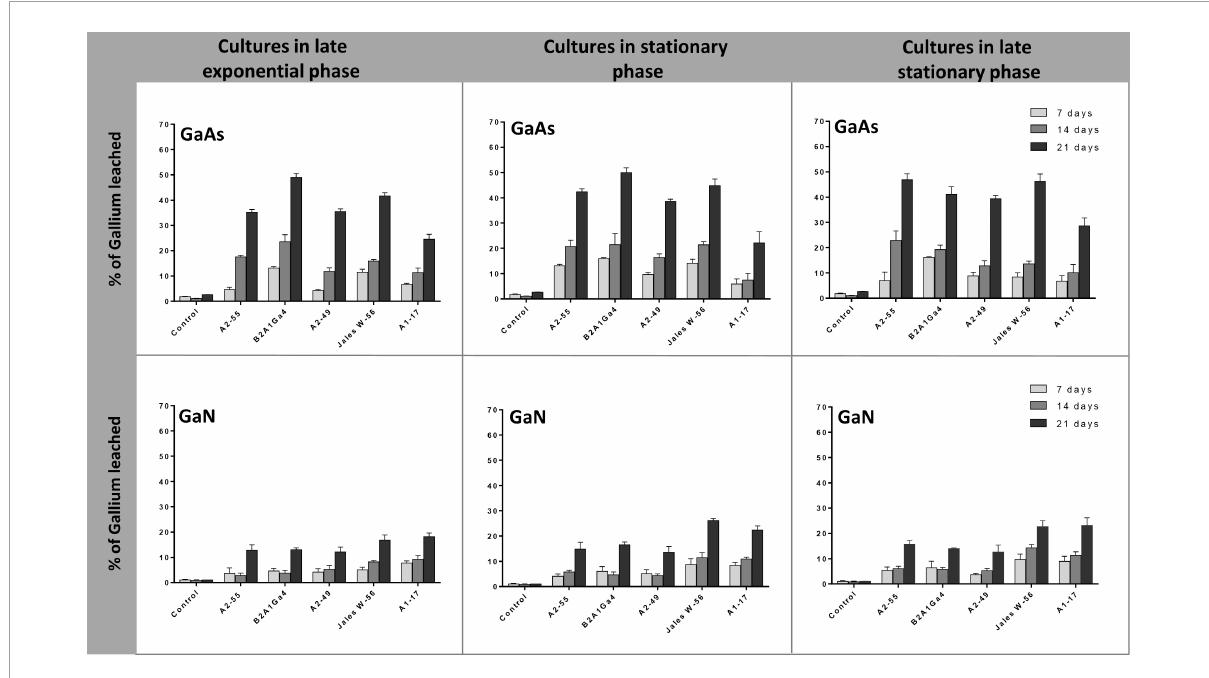
FIGURE4 Gallium leaching from GaAs and GaN by bacterial cultures at different growth phases (late exponential, 8 h; stationary, 24 h, and late stationary, 48 h). Strains: Arthrobacter silviterrae A2-55, Rhodanobacter sp. B2A1Ga4, Sphingomonas sp. A2-49, Undibacterium sp. Jales W-56, and Rugamonas sp. A1-17. Ga in leaching medium was determined at day 7, 14, and 21 of the experiments. Data are the mean values ( ± standard deviations) obtained from two or three independent